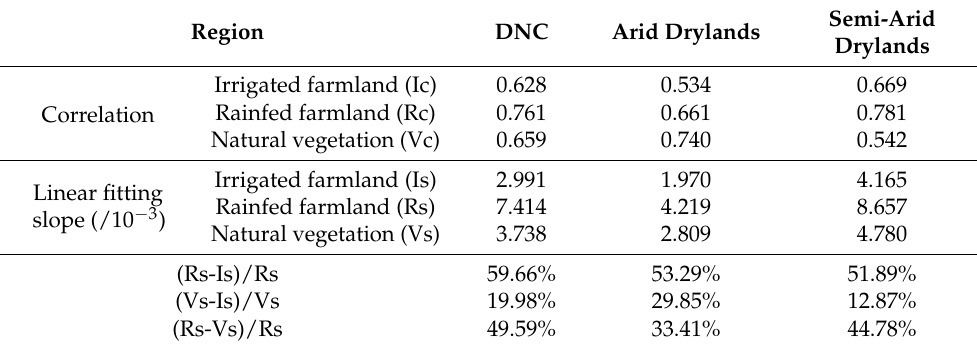
Semi-Arid Drylands